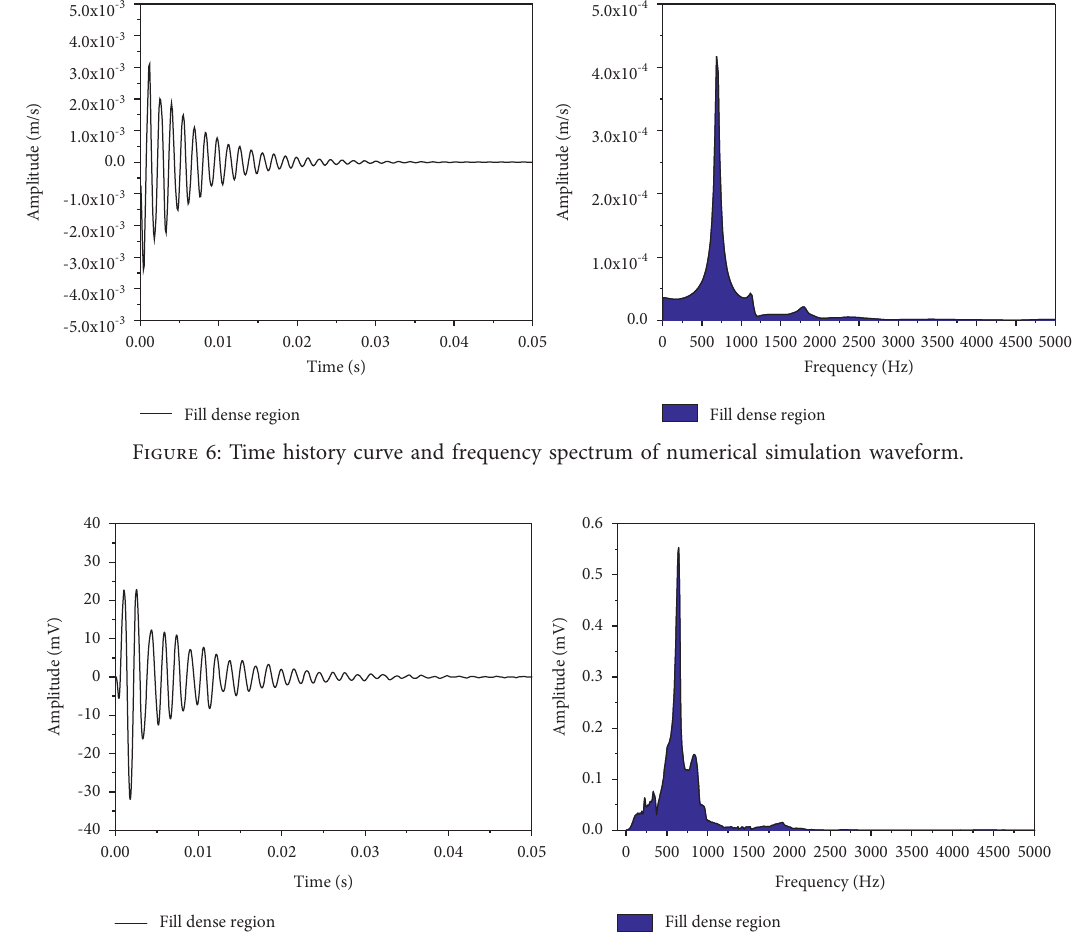
Figure 7: Time history curve and frequency spectrum of experimental waveform.